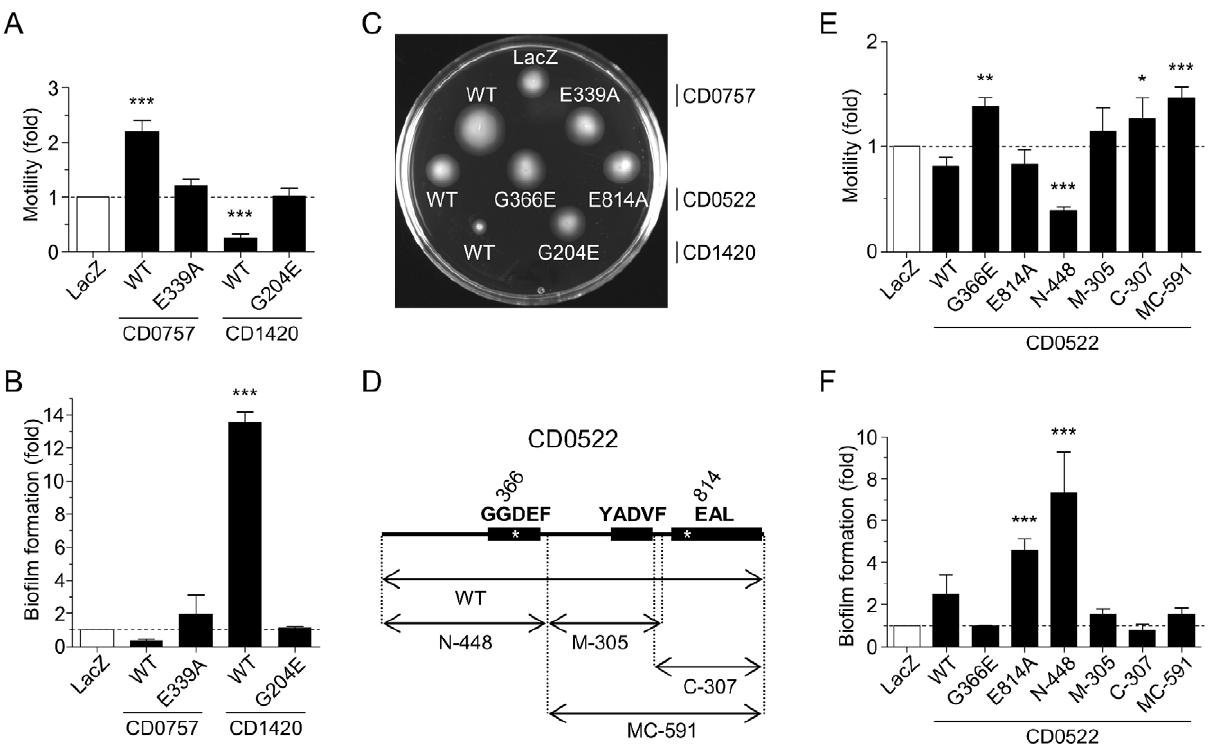
Figure 4. Alteration of V.cholerae N16961 motility and biofilm formation upon expression of wild-type or mutated putative DGCs and PDEAs from C.difficile 630. (A) Relative motility upon expression of wild-type or mutated CD0757 or CD1420. (B) Relative biofilm expression upon expression of wild-type or mutated CD0757 or CD1420. (C) Motility of the strain expressing the wild-type (WT) and mutated proteins on LB soft agar plates at 30 u C. The picture shown is representative of four independent experiments. (D) Schematic representation of CD0522 protein fragments expressed. The amino acids in the signature motifs of the GGDEF or EAL domains are indicated above each domain. Positions of the mutations in the GGDEF or EAL domains are indicated by asterisks. (E) Relative motility upon expression of full-length, mutated or truncated CD0522. (F) Relative biofilm formation upon expression of full-length, mutated or truncated CD0522. The means and standard deviations obtained from four independent assays are shown. One-way ANOVA with a Dunnett multiple comparison post-test was used to compare the cells over-expressing putative c-di-GMP signalling proteins and the control strain (LacZ) (*, P , 0.05; **, P , 0.01; ***, P , 0.001).